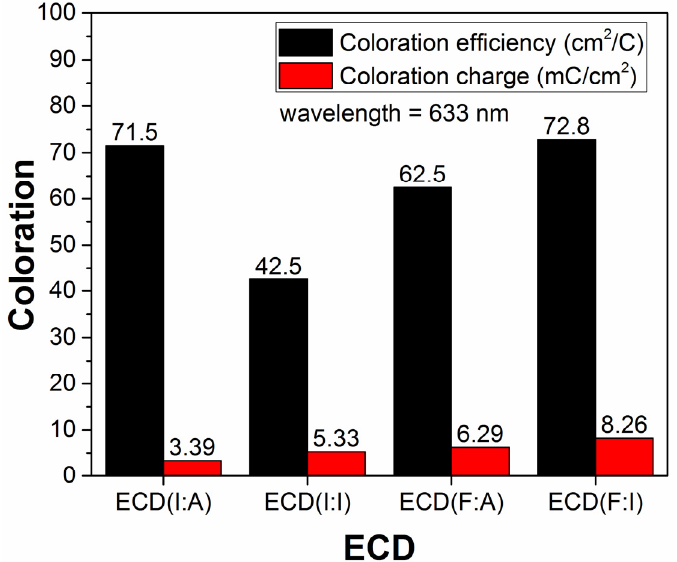
Figure 5. The coloration efficiency and charge of ECD(I:A), ECD(I:I), ECD(F:A), and ECD(F:I) de ‐ vices.